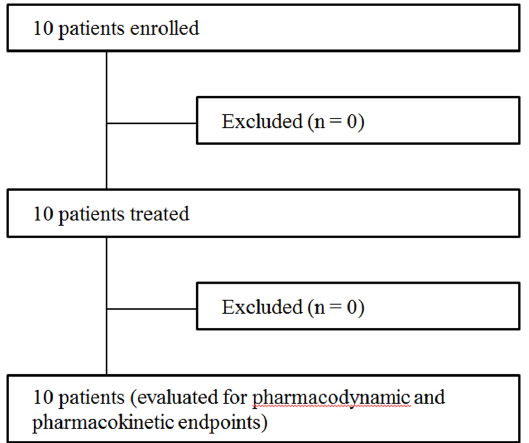
Figure 1. Patient